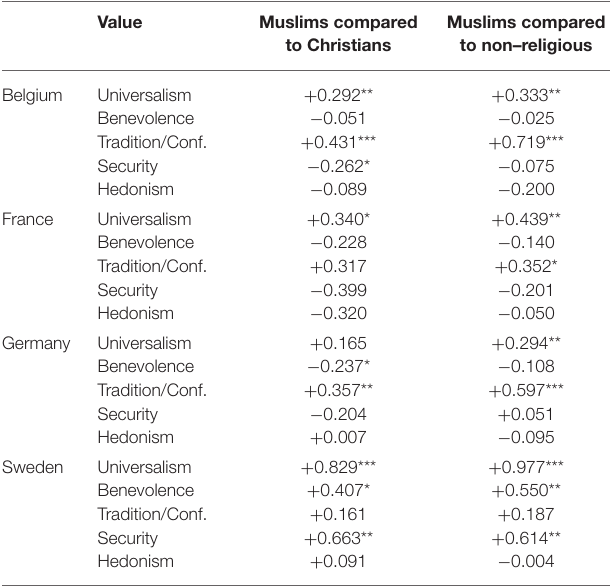
TABLE 7 | Comparisons of latent means of values when controlling for age and education. Value Muslims compared Muslims compared to Christians to